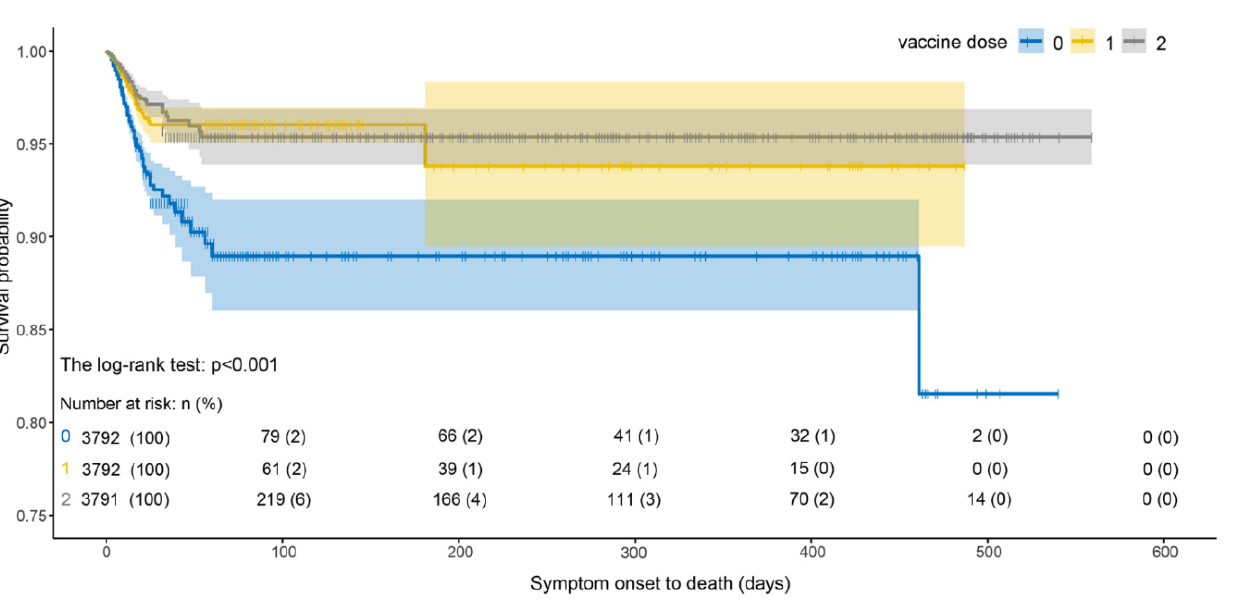
Figure 5. Multiple PSM processes and the odds/hazard ratio of vaccine doses on SOD. Panel ( a ) is the flowchart of multiple PSM for vaccine doses, and panel ( b ) shows the estimated OR/HR values of vaccine doses, where only the ratio of the fourth wave is HR and others are OR.